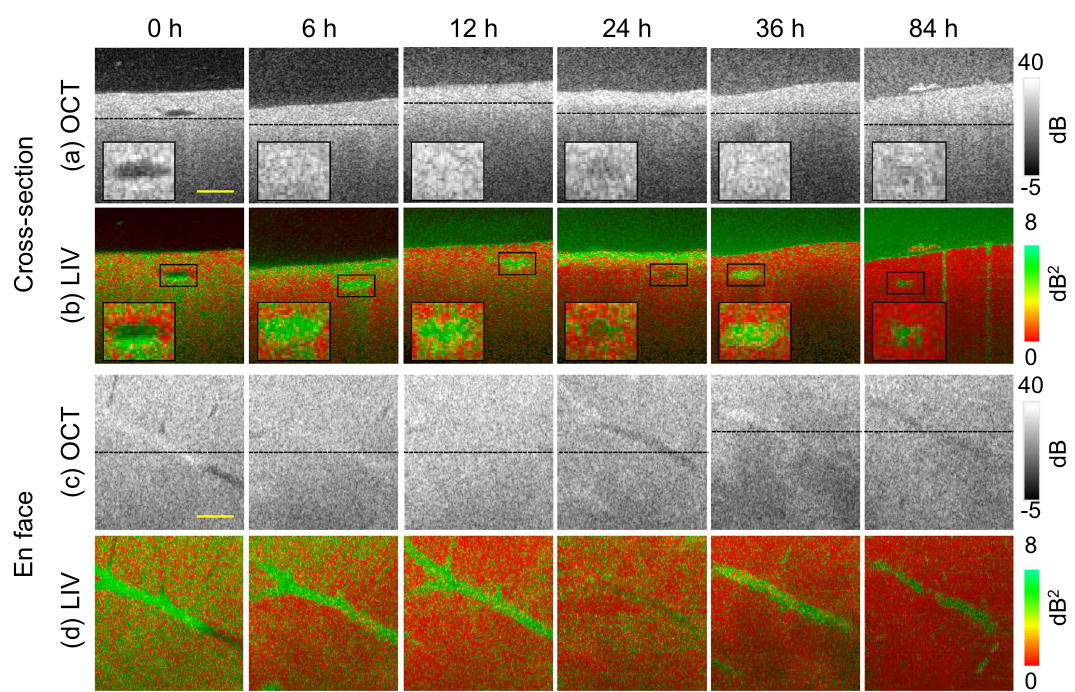
Figure 4. Longitudinal dynamics visualization of healthy liver microvasculature. The first and second rows ( a , b ) show cross-sectional and the third and fourth rows ( c , d ) show en face slices of the OCT and LIV images, respectively. The first to fourth rows show the time-course images at the 6, 12, 24, 36, and 84 h time points. Scale bar: 250